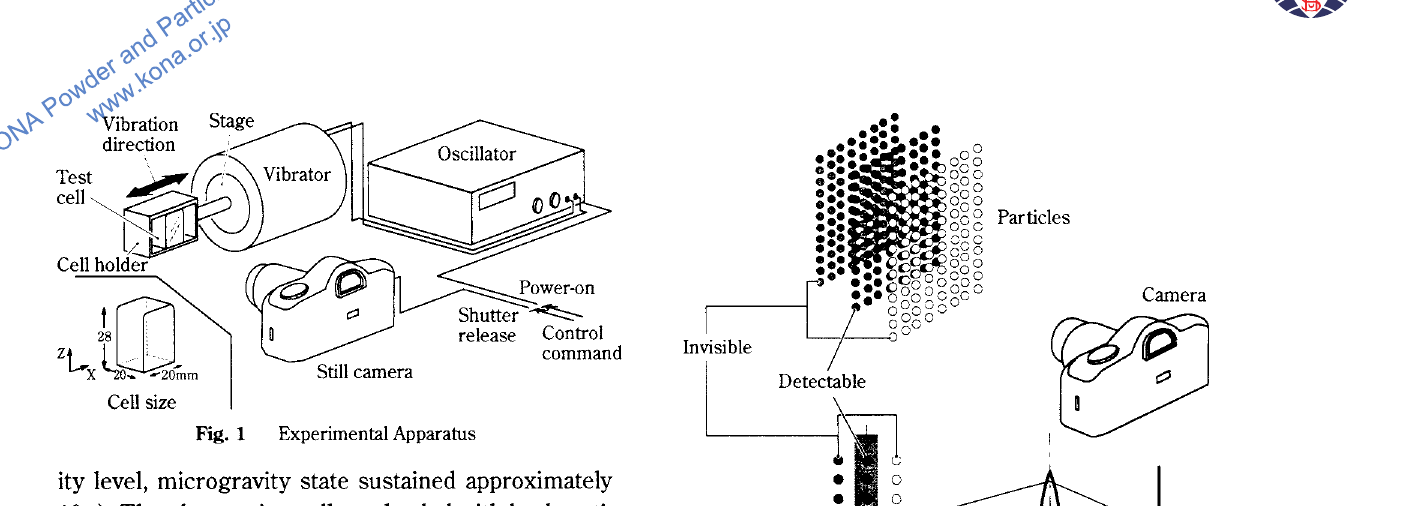
Experimental Apparatus